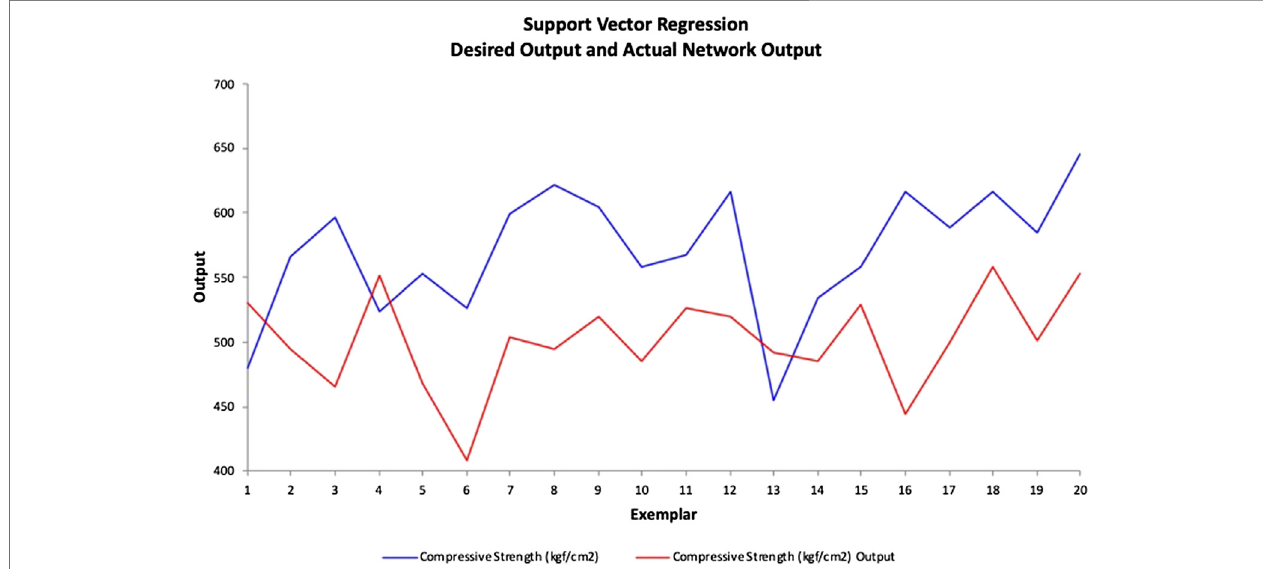
FIGURE 14 | Support vector regression model line